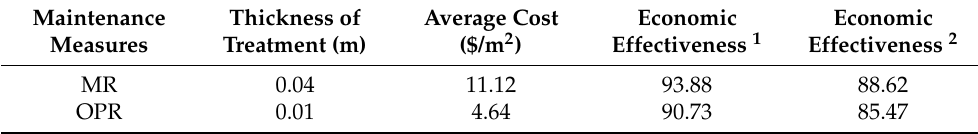
Table 9. The average cost and economic effectiveness of the two maintenance measures.